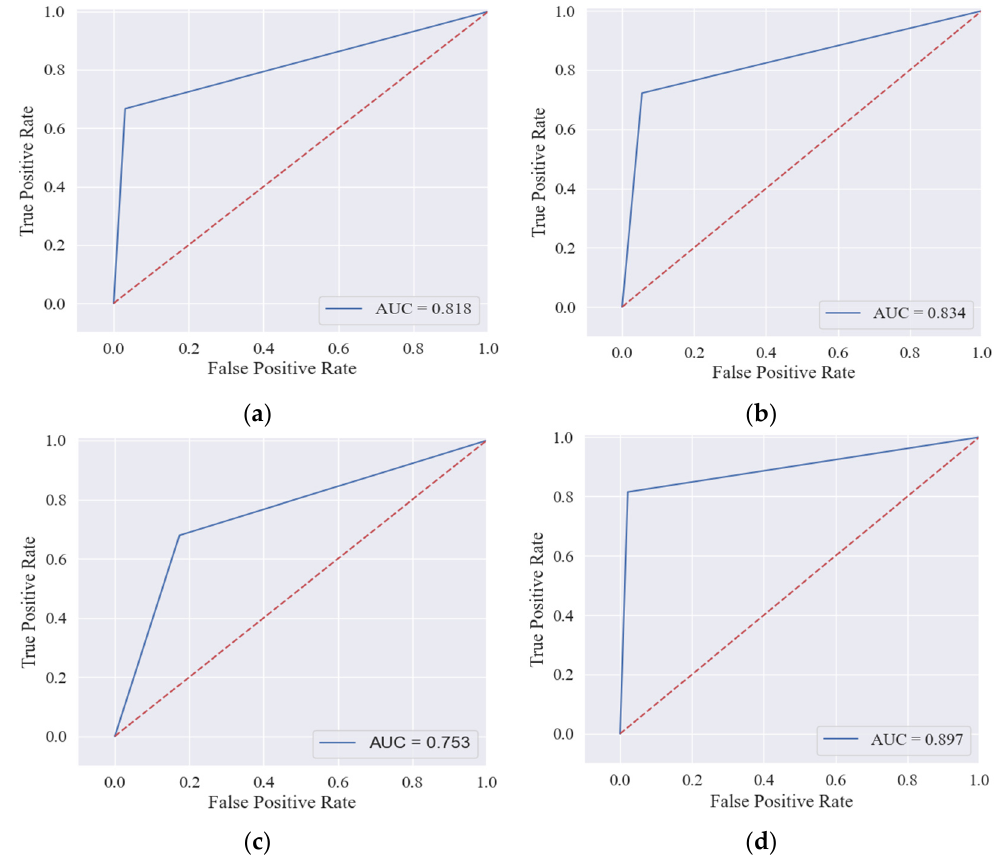
Figure 10. Receiver operating characteristic of the proposed feature sets in ( a ) opcodes n-gram, ( b )